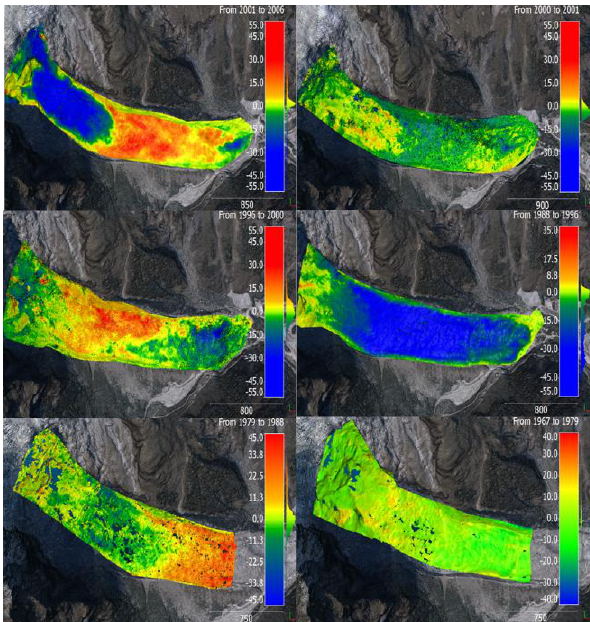
Figure 7 . Evolution and distribution of mass loss in Brenva Glacier from 1967 to